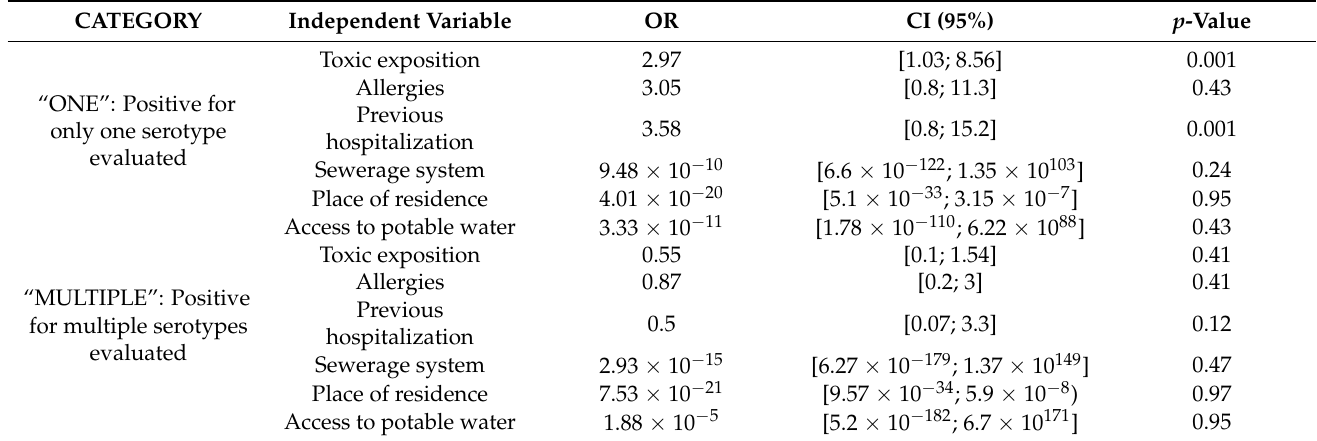
Table 4. Variables included in the multinomial logistic regression